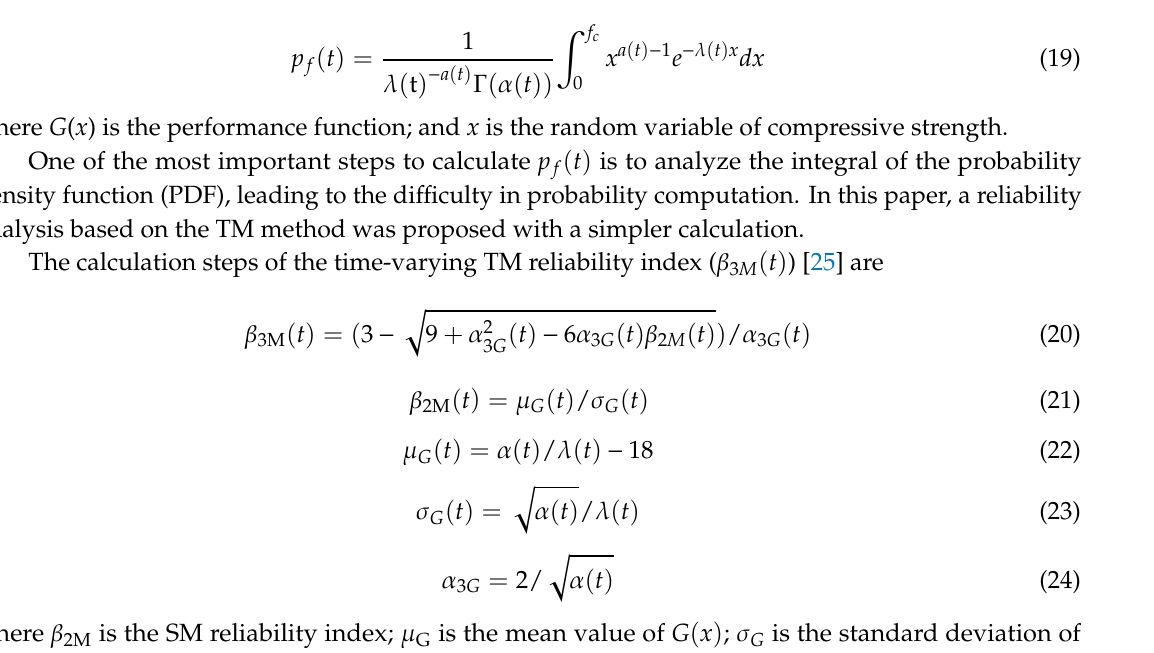
f Figure 14. Scale parameter ( λ = 21.0N/mm 2 c